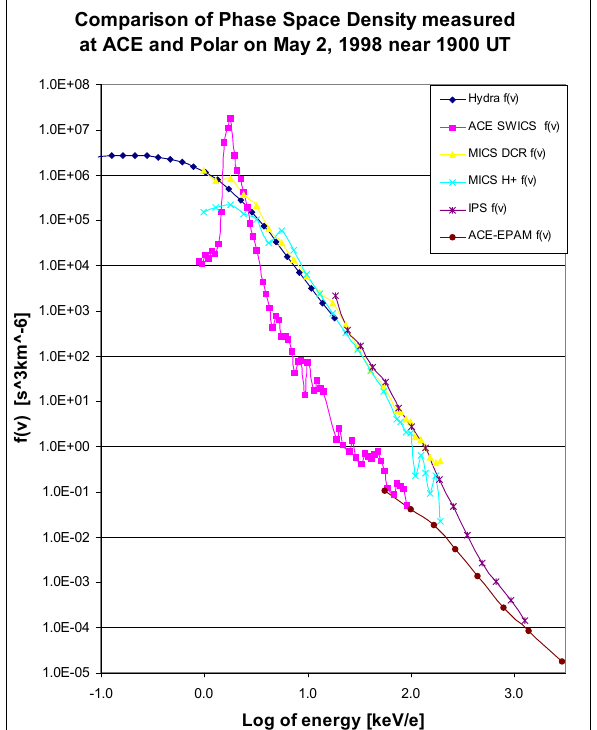
Fig. 2. The phase space density of the total ion population deter- mined by the SWICS and EPAM instruments at ACE and by the HYDRA, MICS, and IPS instruments on Polar, as a function of en- ergy/charge. The two populations correspond to a plasma with an average Fe charge state of +15 recorded just before 19:00UT on 2 May at ACE and just after 19:00UT at Polar.